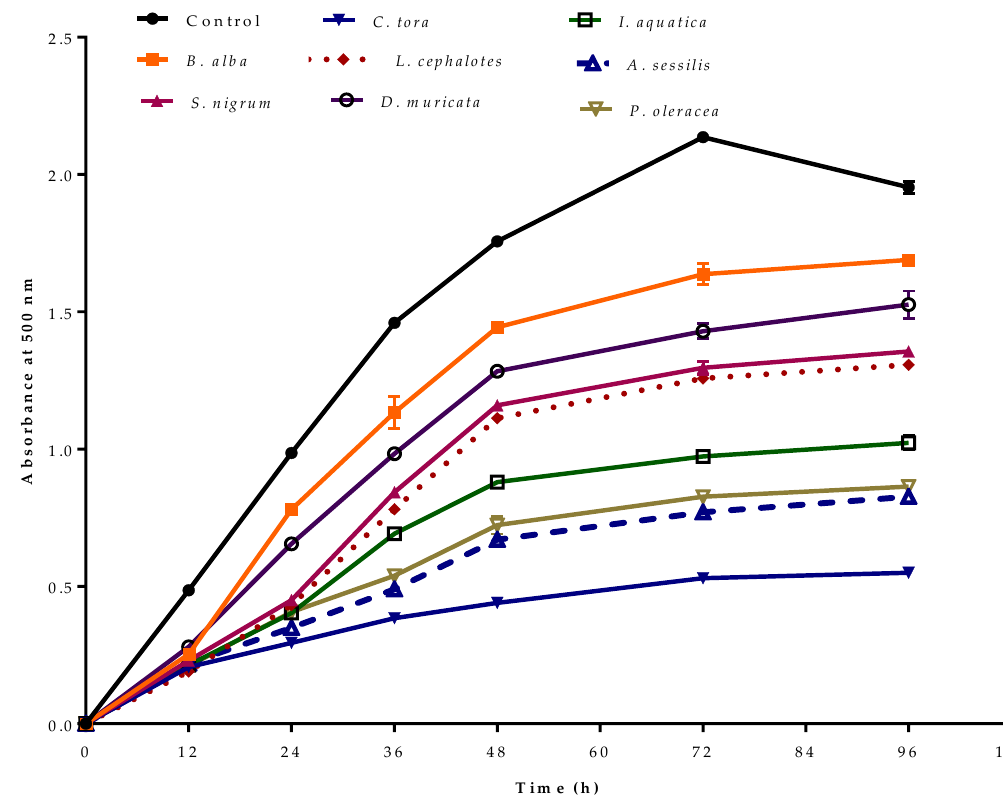
Figure 4. Antioxidant activity of selected wild leafy plants by ferric thiocyanate method–linoleic acid system at different time intervals. Results expressed as the mean ± standard deviation (n = 3) at a concentration of 100 µg/mL.